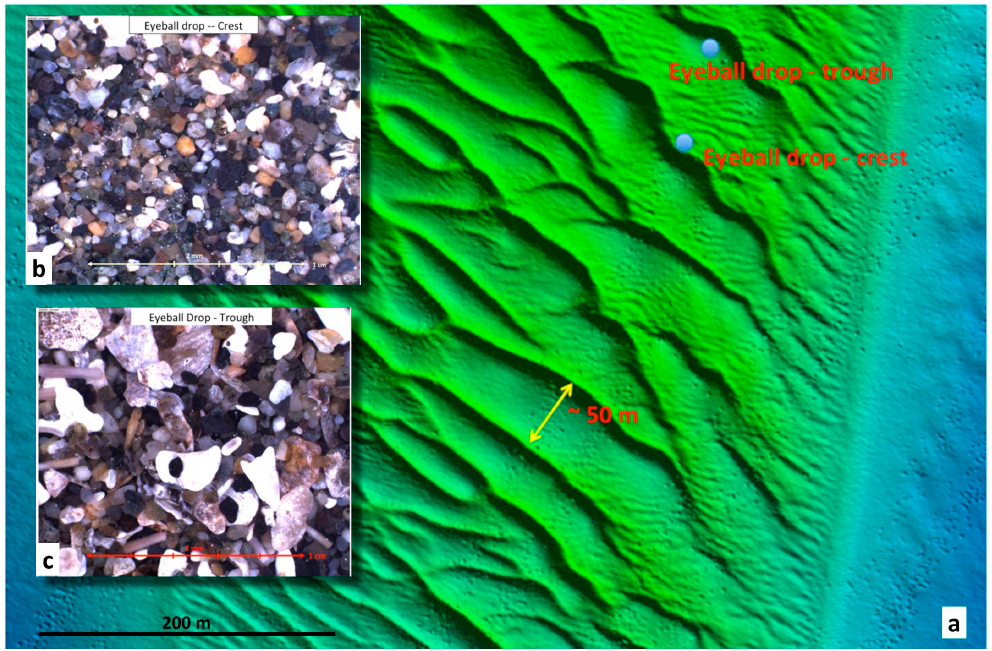
Figure 4. Examples of images collected using the USGS eyeball camera: ( a ) MBES bathymetric image with locations of samples collected in the sand wave field; ( b ) photo of sediment taken in trough; ( c ) photo of sediment taken near crest of a sand wave.